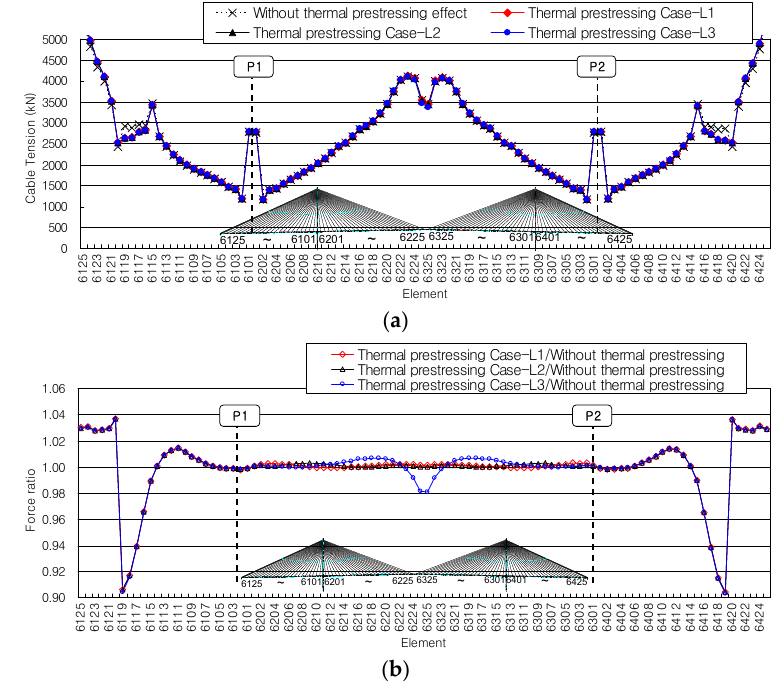
Figure 9. Cable forces according to the heating region. ( a ) Cable forces after completed construction; ( b ) Cable force ratio.